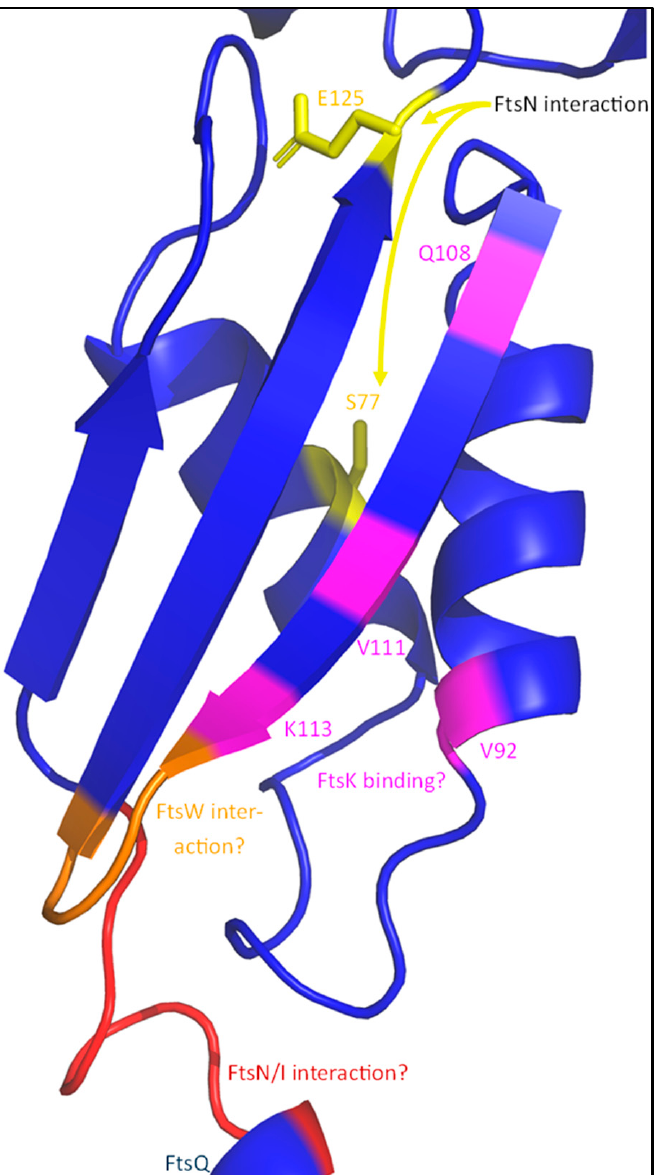
Figure 11. The FtsQ POTRA domain. FtsQ interacts with multiple divisome proteins through its POTRA domain, which is part of the membrane-proximal periplasmic domain. A loop between the TM domain and the first strand of the β -sheet (50–57 in red) is necessary for the interaction with FtsI (and FtsN). Additional FtsN interacting residues are shown in yellow (S77, E125). The POTRA domain also contains a FtsK-binding site (purple), which includes a hydrophobic pocket (V92, V111, L57). Furthermore, a FtsW interaction interface is expected somewhere in the region between Q108 and E125. This is likely the loop between the two strands of the β -sheet, as this is the region predicted to be closest to the membrane-embedded FtsW (orange).